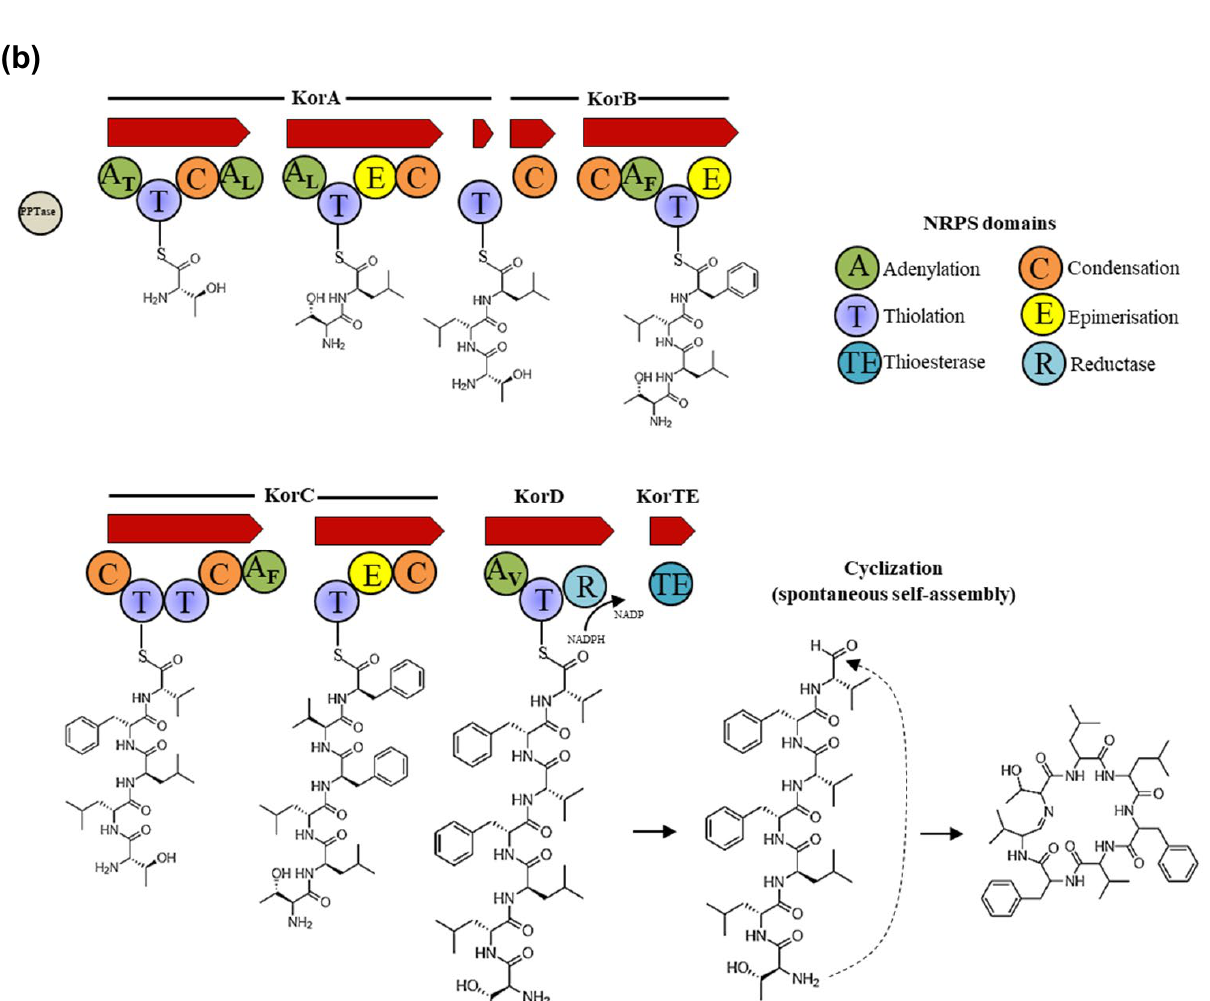
Figure 4. Characterization of koranimine biosynthetic gene cluster. ( a ) Comparison of koranimine biosynthetic gene cluster (BGC) gene organization detected in Peribacillus frigoritolerans BE93 with that of Bacillus sp. NK2003. ( b ) Non-ribosomal peptide synthase (NRPS) domains and modules found in the BE93 koranimine BGC and the proposed pathway for the biosynthesis of